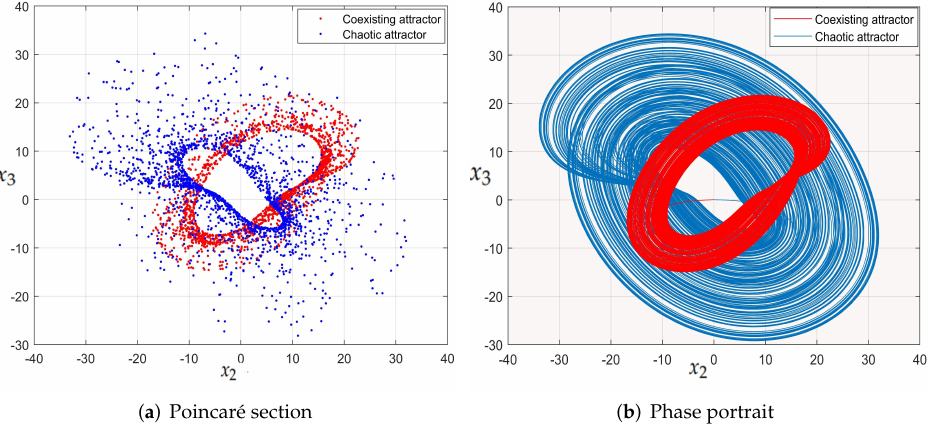
Figure 11. Poincaré section and corresponding phase portrait of chaotic attractor vs. coexisting attractor in system (2) for x 2 – x 3